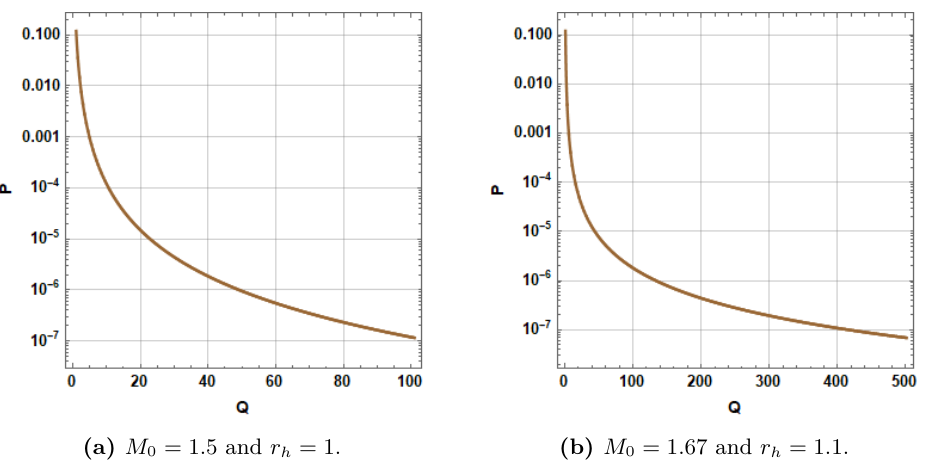
Figure 32. Black hole pressure as a function of electric charge during a constant electric potential absorption. The initial conditions are Q 0 = 1 , l = 1 , and D = 4